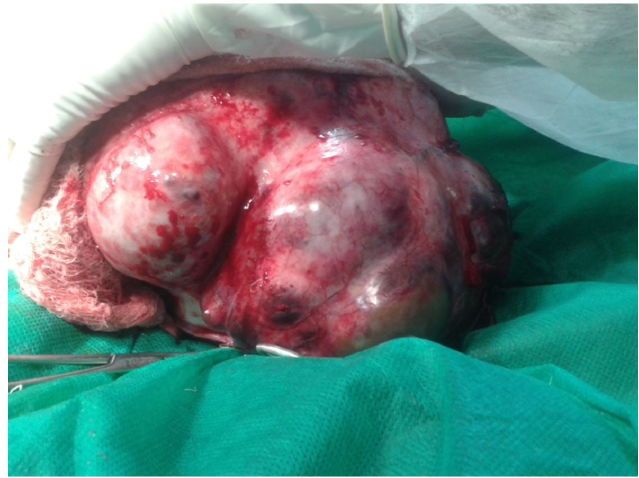
Figure 2. Surgical resection and macroscopic appearance of the right